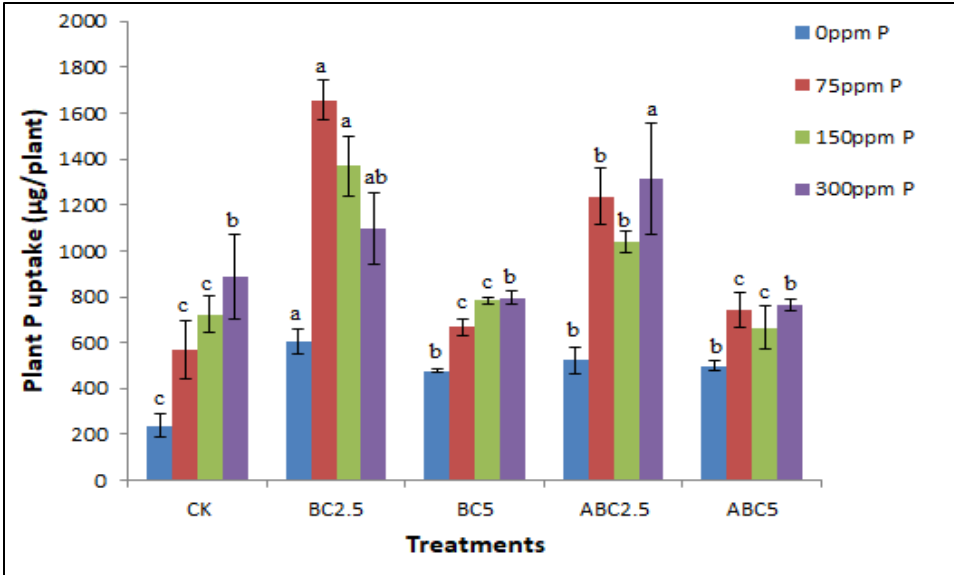
Figure 8. Effects of BC and ABC applied at different rates with different P fertilizer application rates on plant P uptake in shoots in microgram/plant. Means with different letters within each fertilizer rate across each treatment indicate significant differences according to the least significant difference (LSD) test at p < 0.05. CK = Control, BC2.5 = Biochar added at 2.5% w / w , BC5 = Biochar added at 5% w / w , ABC2.5 = Acidified biochar added at 2.5% w / w , and ABC5 = Acidified biochar added at 5% w / w .